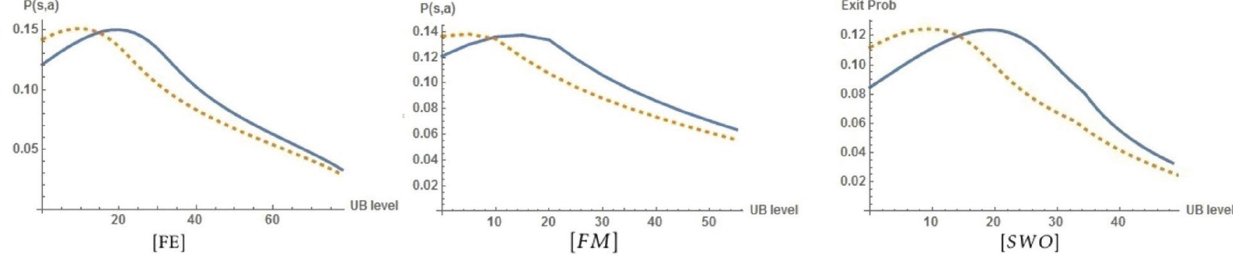
Figure 8 Cash Transfer Effect. These graphs show the job-finding probability P for different values of b , for the extensions: [FE], [FM], and [SWO]. The continuous line is generated with the functions and parameters discussed in the previous section for each model, and the dashed line is generated with the same pa- rameters except for the fact that the agent receives a transfer of 10 regardless of her employment